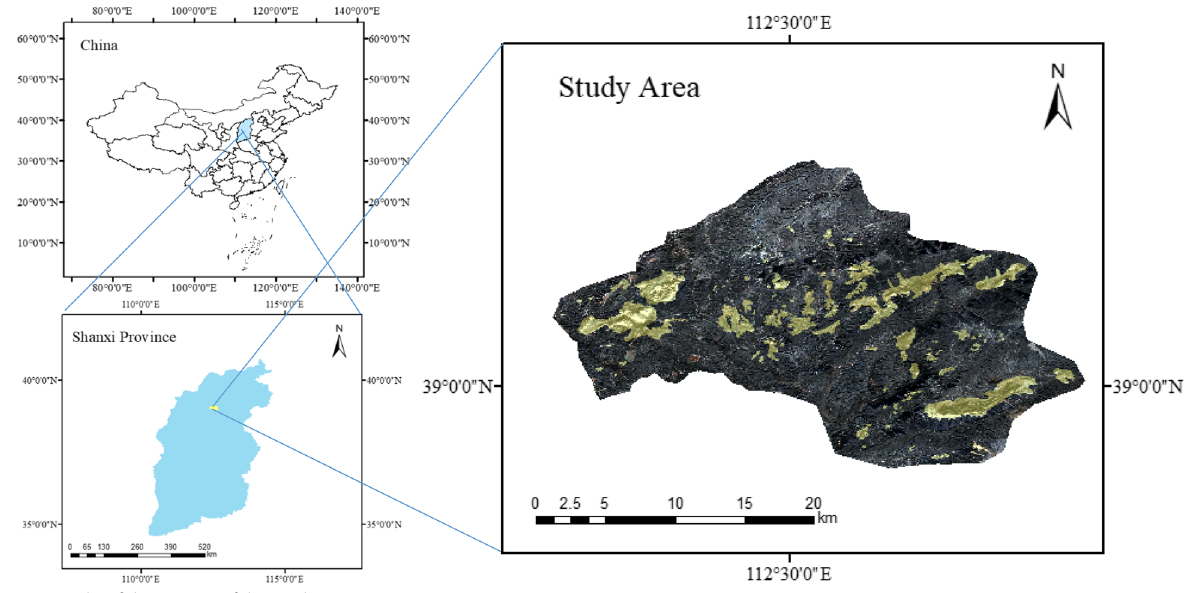
Fig. 1 A brief description of the study